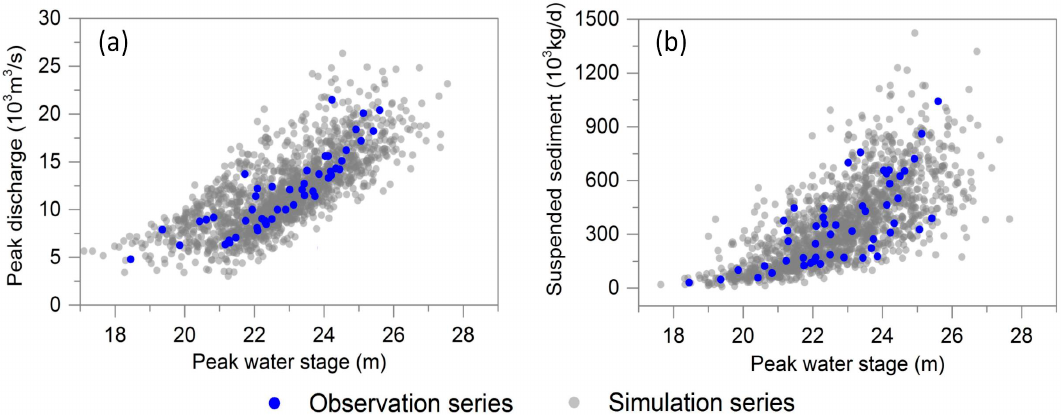
Figure 4. Scatter plots of Z-Q ( a ) and Z-S ( b ) shown comparison of observed data with sets of 1500 generated random samples based on the selected bivariate copulas. Solid circles in blue color are observed data and gray dots are simulated samples.